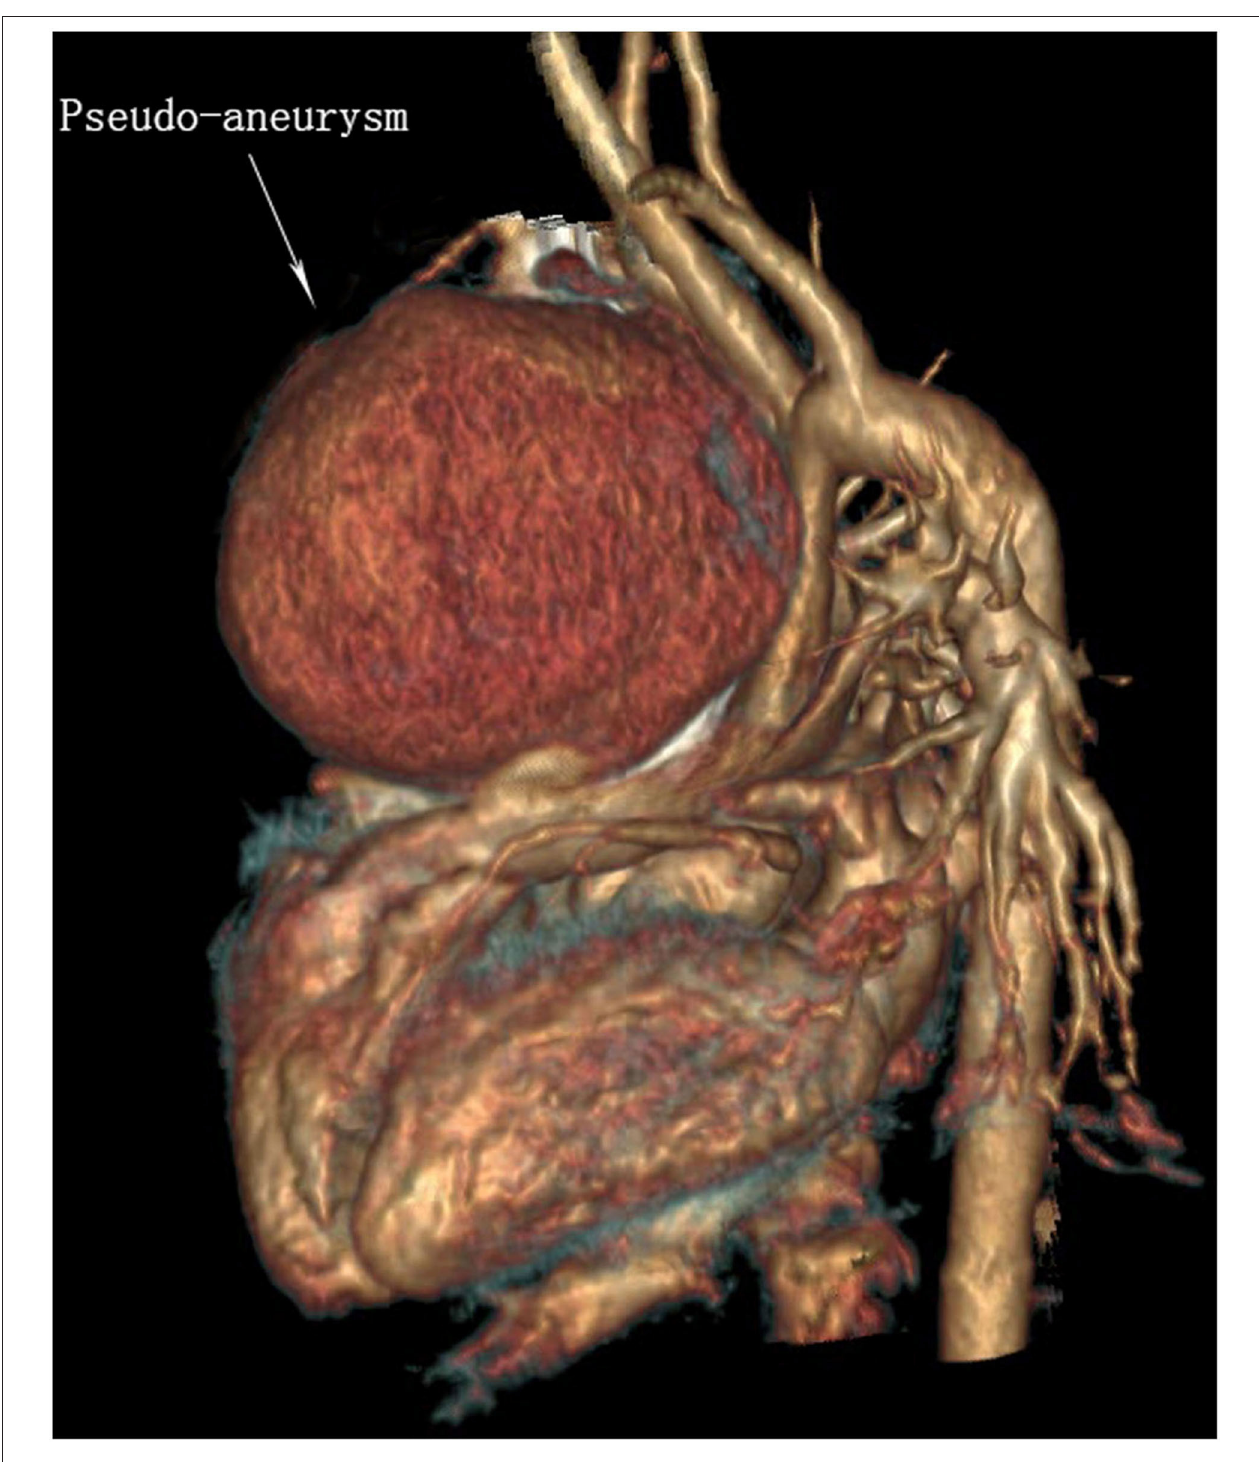
FIGURE 3 | 3D reconstruction of sagittal view of contrast enhancement CT image suggests a large pseudo-aneurysm is bound up with the ascending aorta.